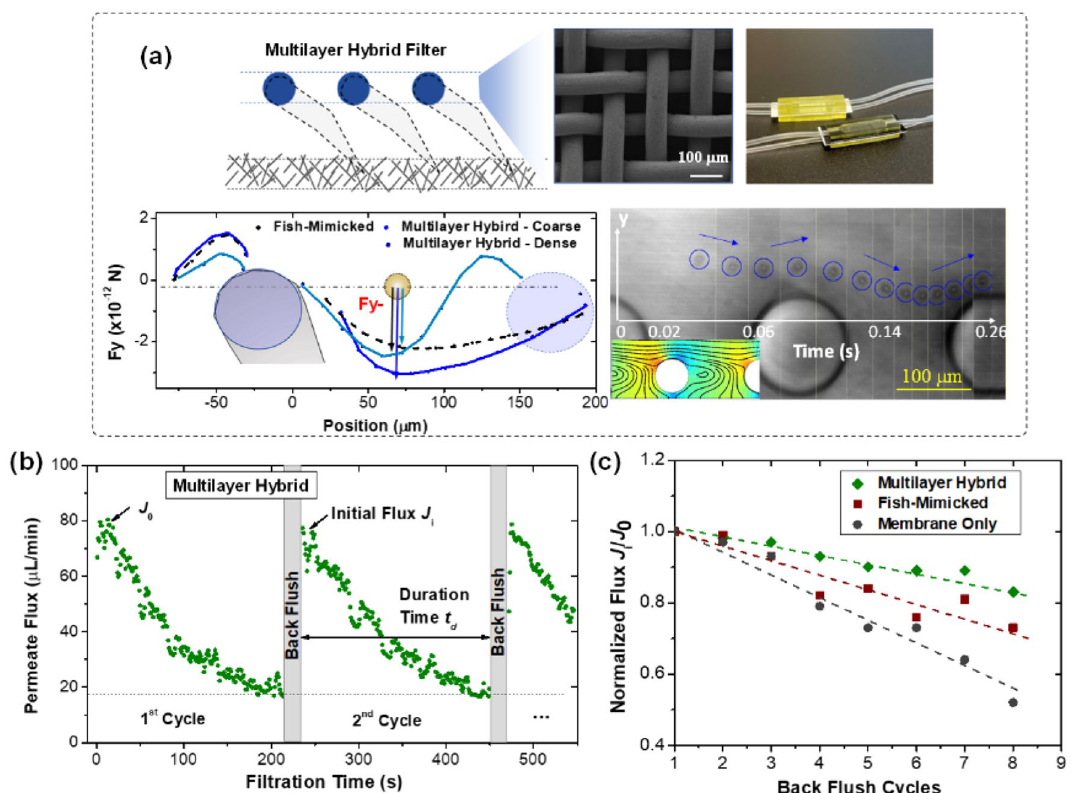
Figure 5. Scalable multilayer hybrid filtration device and flux recovering performance with backflush cleaning. ( a ) Mesh-covered multilayer hybrid filter. The subfigures are mesh surface morphology from SEM images, device outlook from optical images (also see the cross-sectional view of device in Fig. S2b,c), force analysis from simulation results, and ricochet behavior of droplet from flow imaging, respectively. ( b ) Permeate flux change after each backflush cycle of multilayer hybrid filter. ( c ) Comparison of the normalized flux among three different membrane